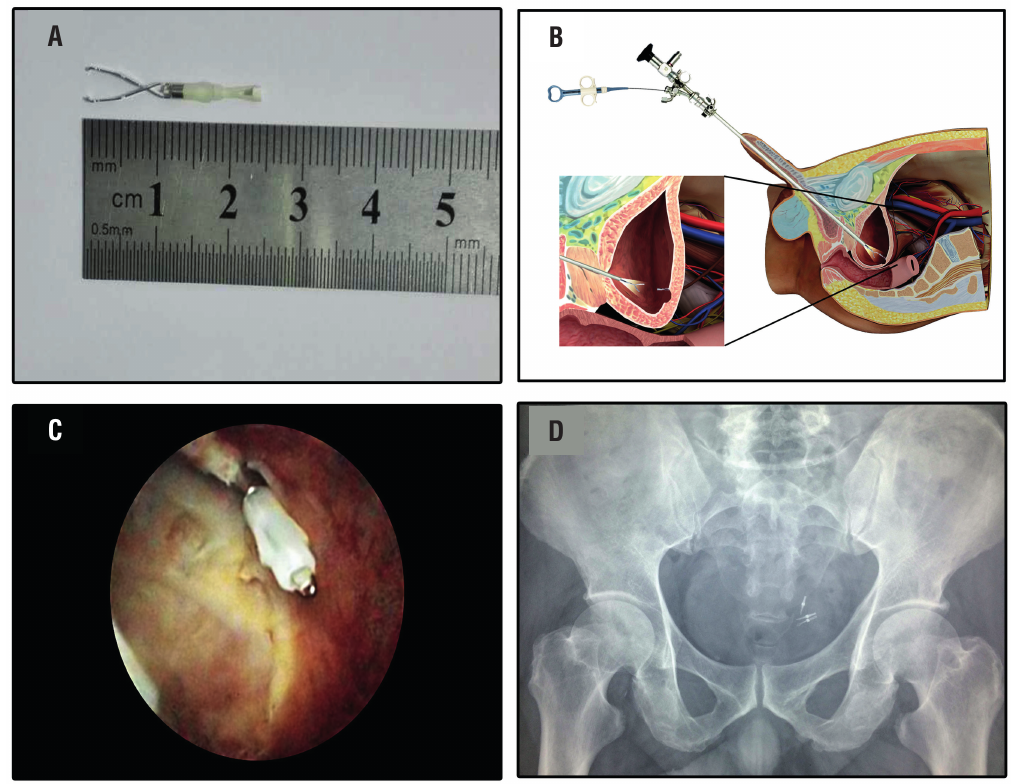
(A) Close-up view of a titanium endoclip used as a novel fiducial marker; (B) Endoclip application via a rigid cystoscope. The inset shows a